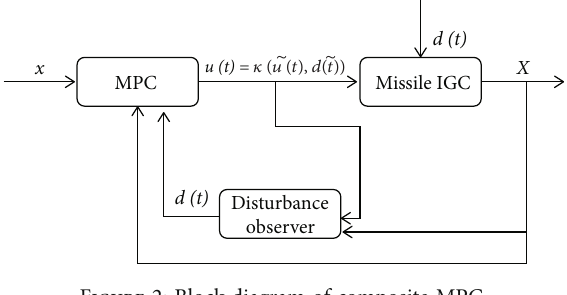
Figure 2: Block diagram of composite